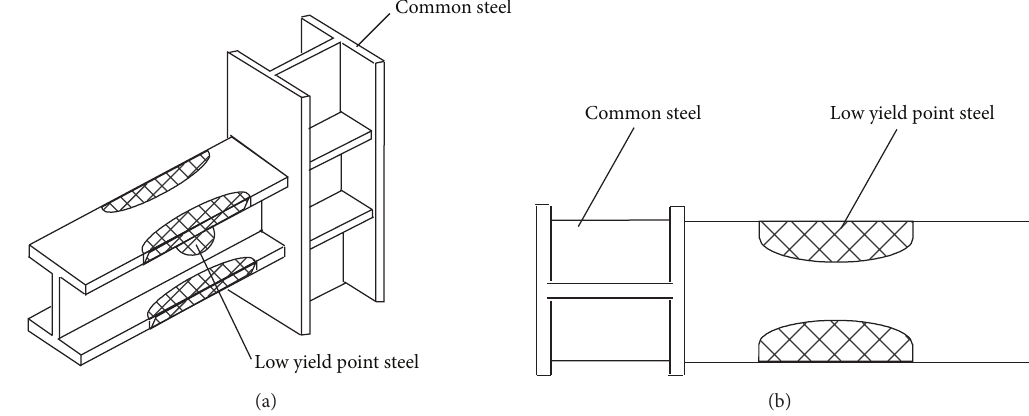
Figure 2: (a) Side view of beam end weakened replaceable connection and (b) top view of connection.